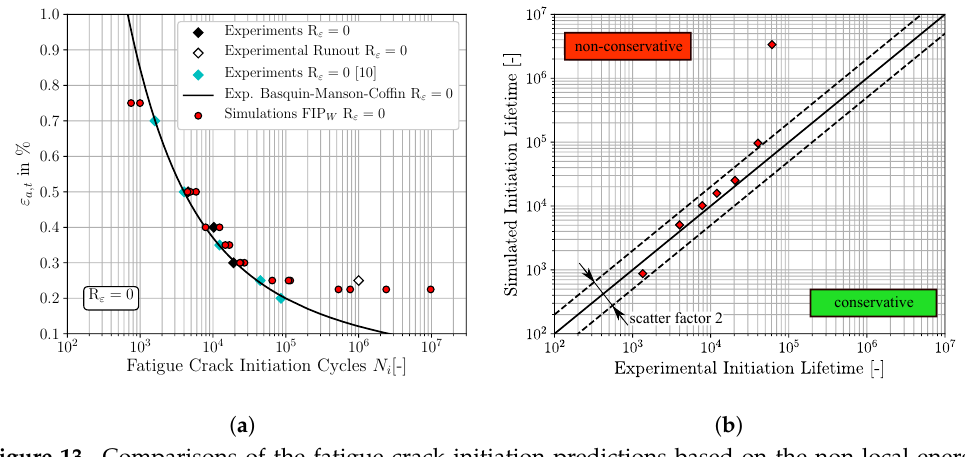
Figure 13. Comparisons of the fatigue crack initiation predictions based on the non-local energy dissipation criteria and the experimental fatigue crack initiation lifetime, for R ε = 0: ( a ) ε -N-curve ( b ) lifetime correlation